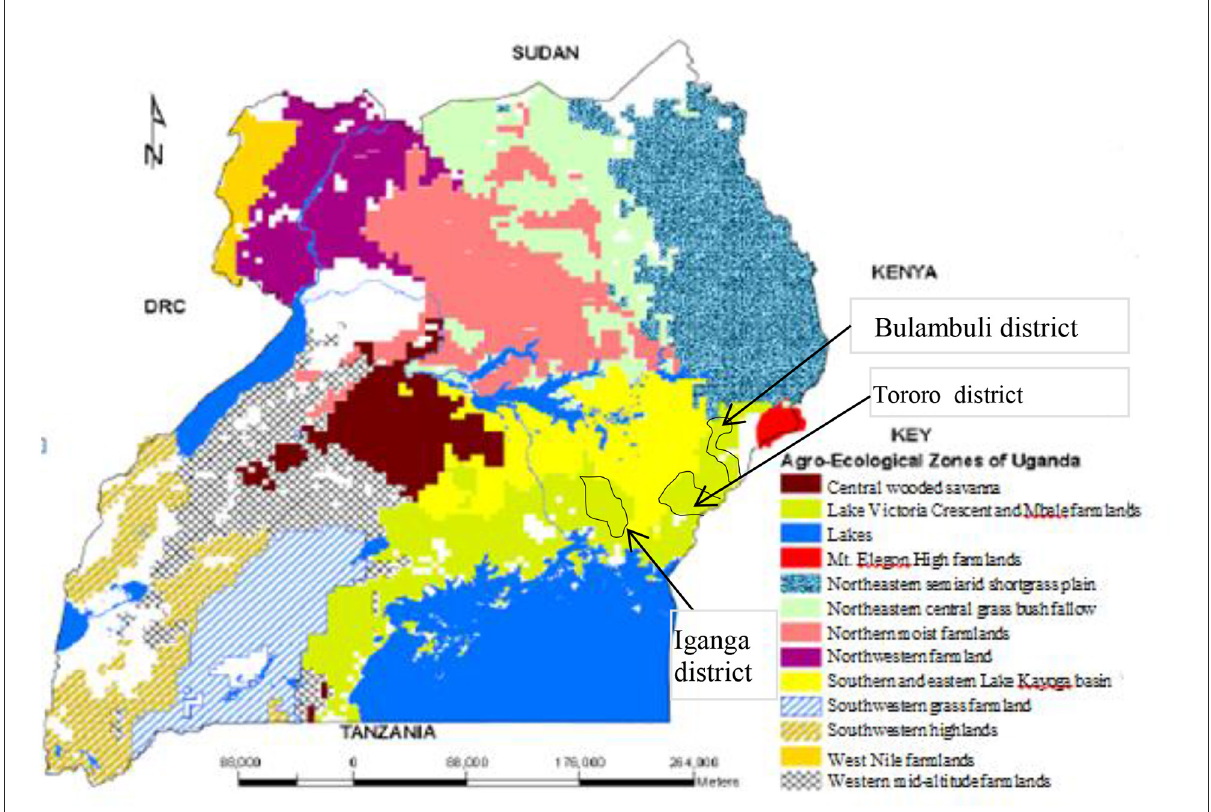
FIGURE1 Agro-ecological zones of Uganda, and location of sampled districts. Source: Wasige